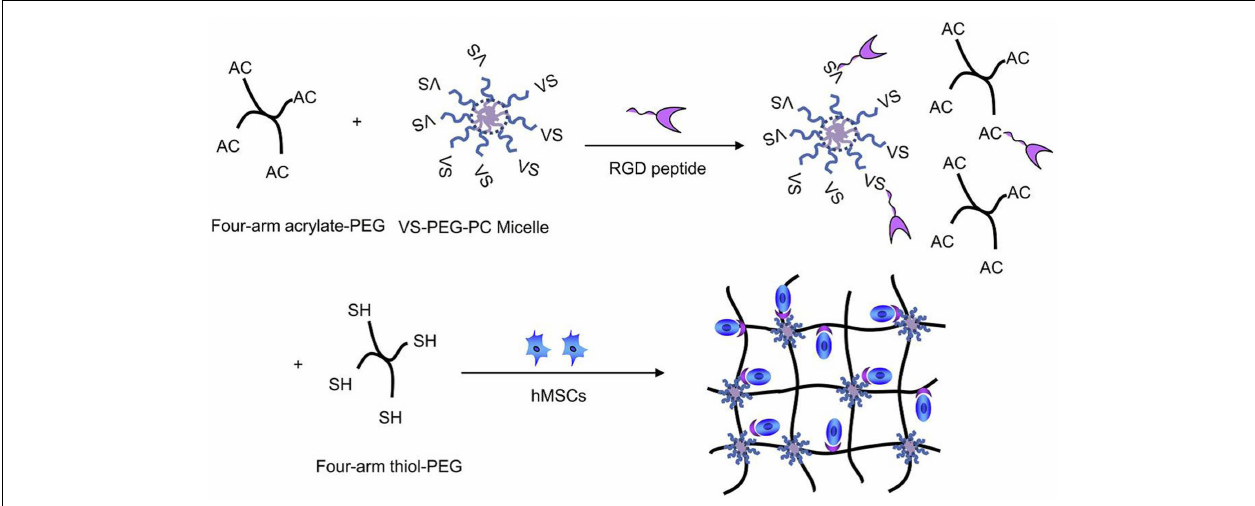
FIGURE 4 | Synthesis of hydrogel with micellar crosslinks and a peptidic structure to bind human mesenchymal stem cells (hMSCs);VS stands for vinyl sulfone . Reprinted from Li et al. (2012) with permission.